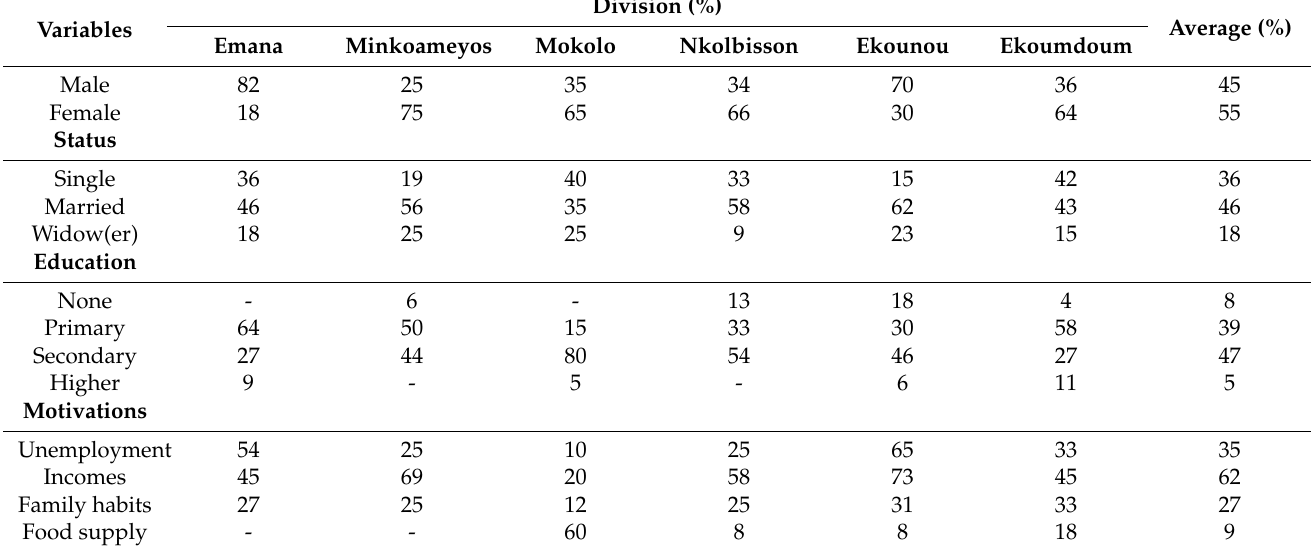
Table 1. Farmer’s socio-demographic profile ( N =